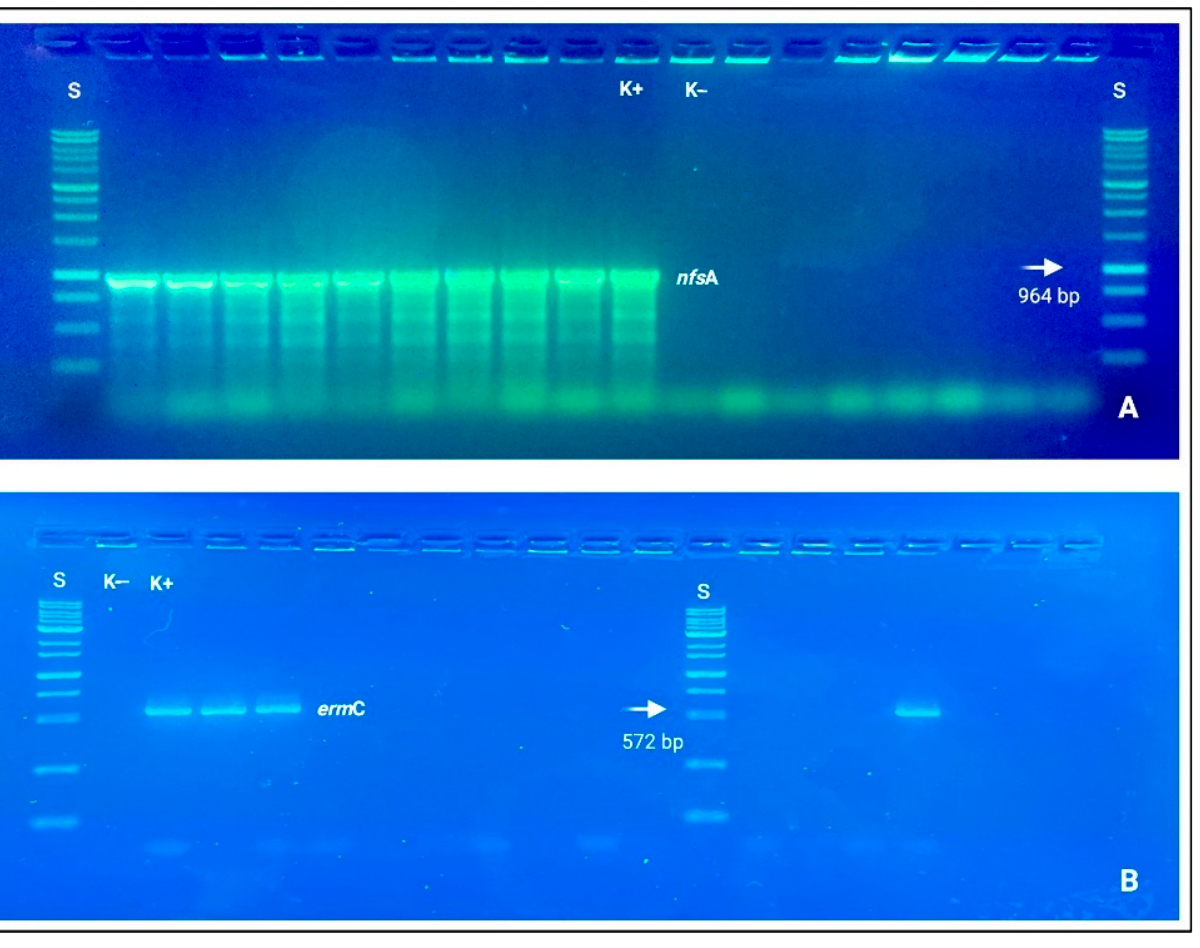
Table 8. ARGs detection from resistant and susceptible bacterial strains.